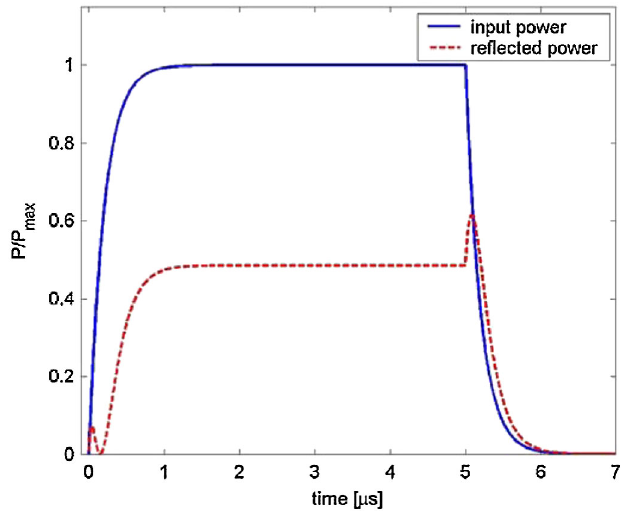
FIG. 4. (Color) Time domain cavity response to a step input in case of (cid:4) ¼ 5 : 6 (blue: rf input pulse; red: cavity reflected power).